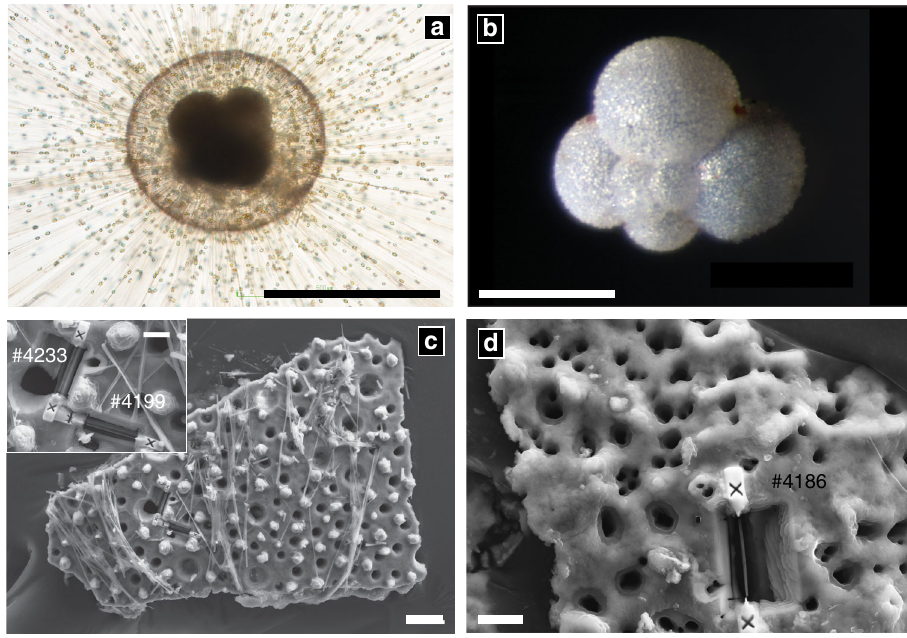
Fig. 1 The structure of foraminiferal shells. a Orbulina universa develops a fi nal, large, spherical chamber, which encloses the earlier formed spiral shell of its ‘ juvenile ’ stage (dark, centre). The shell supports long radiating mineralised spines that host a sticky network of streaming rhizopodia that are used to trap prey, take up and excrete material, and deploy algal symbionts. This fi nal spherical chamber is initially thin-walled and thickens continuously over 3 to 7 days. Near the end of the foraminifer ’ s life cycle 47 , the spines are shed and O. universa undergoes a massive release of gametes, leaving an empty shell that sinks rapidly to the sea fl oor, exporting CaCO 3 from the surface ocean. b Neogloboquadrina dutertrei form trochospiral shells of consecutively larger chambers, and do not have mineralised spines or symbionts. Electron-transparent foils were extracted orthogonally from the outer surface (Session 1) or polished cross-sections (Session 2) of pre-gametogenic O. universa ( c ) and N. dutertrei ( d ) shell fragments using a FIB. The pits in the images show the locations of foil extraction with foil identi fi cation numbers. Scale bars are 500 µ m ( a ), 200 µ m ( b ), 20 µ m ( c ), 5 µ m (inset), 5 µ m ( d